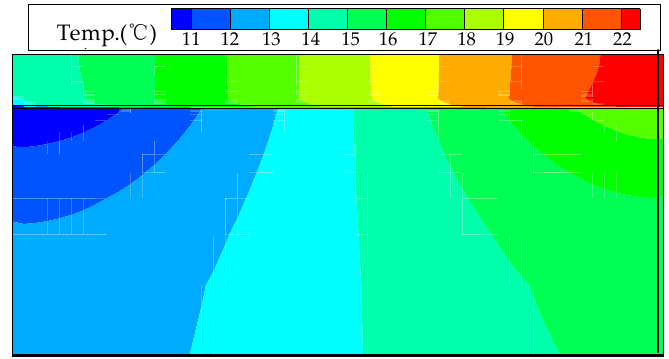
Figure 12. Temperature distribution of the prototype.